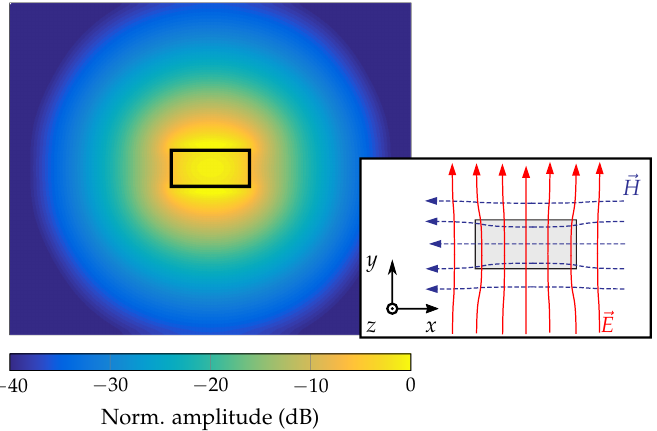
Figure 2. E-field distribution of the fundamental HE 11 mode in a dielectric waveguide with polarization in y -direction [12]. c IEEE 2017 (cid:13)